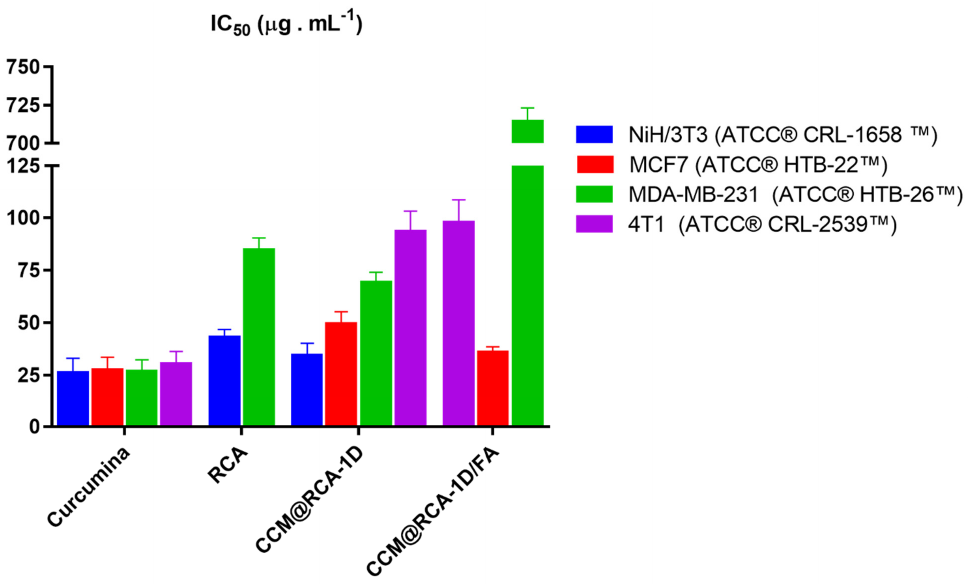
Figure 14. Graph representing IC 50 values of RCA, CCM, compounds CCM@RCA − 1D and CCM@RCA − 1D /FA in cell line 4T1, MCF − 7, MDA-MB-231, and NiH/3T3.